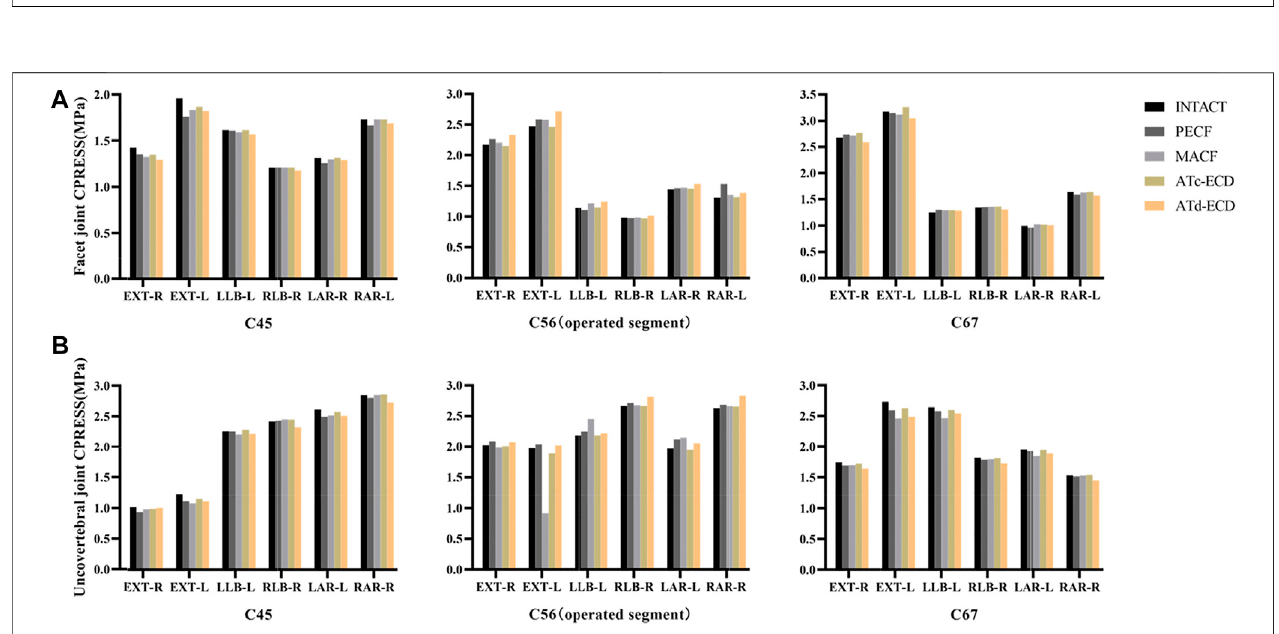
FIGURE 6 | The AFP and IDP of C4 – C5, C5 – C6, and C6 – C7 in the intact model and surgical models. ( A ) Intradiscal pressure. ( B ) Annulus fi brosus pressure. FLE, fl exion; EXT, extension; LLB, left lateral bending; RLB, right lateral bending; LAR, left axial rotation; RAR, right axial rotation.